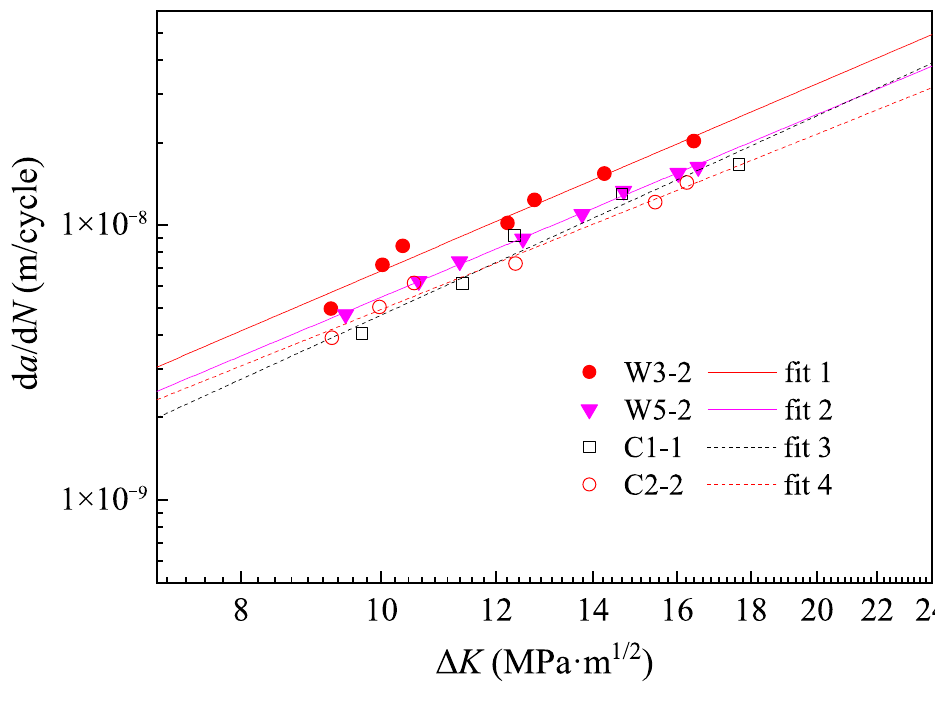
Figure 20. Fitted curves of Paris region.